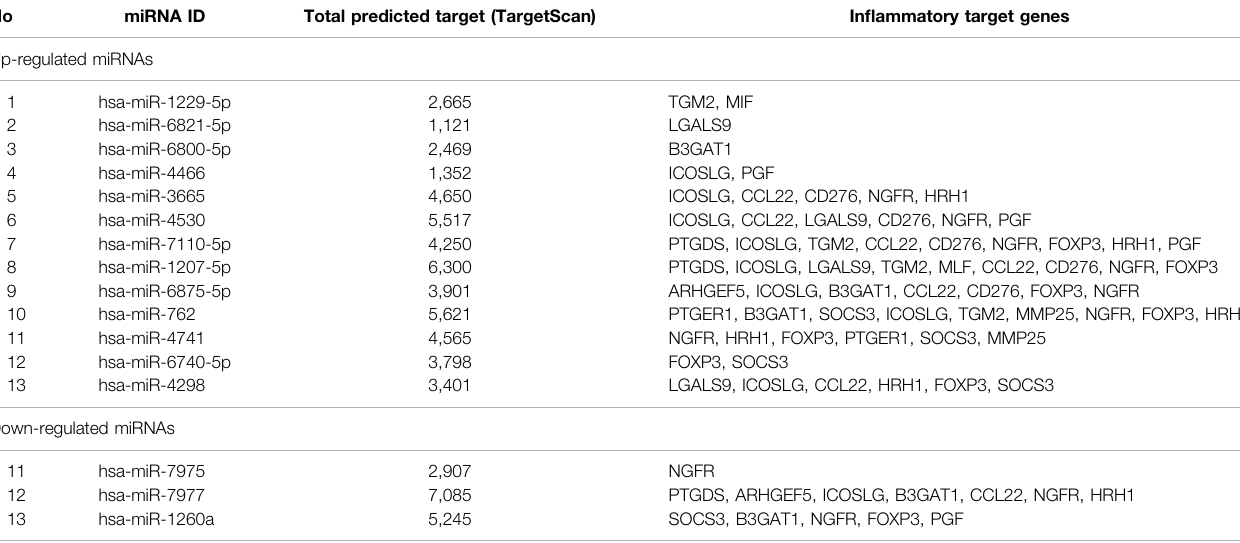
TABLE 3 | Top 13 up-regulated and three down-regulated miRNAs in children with VKC in comparison to controls along with their conjunctivitis related gene targets. No miRNA